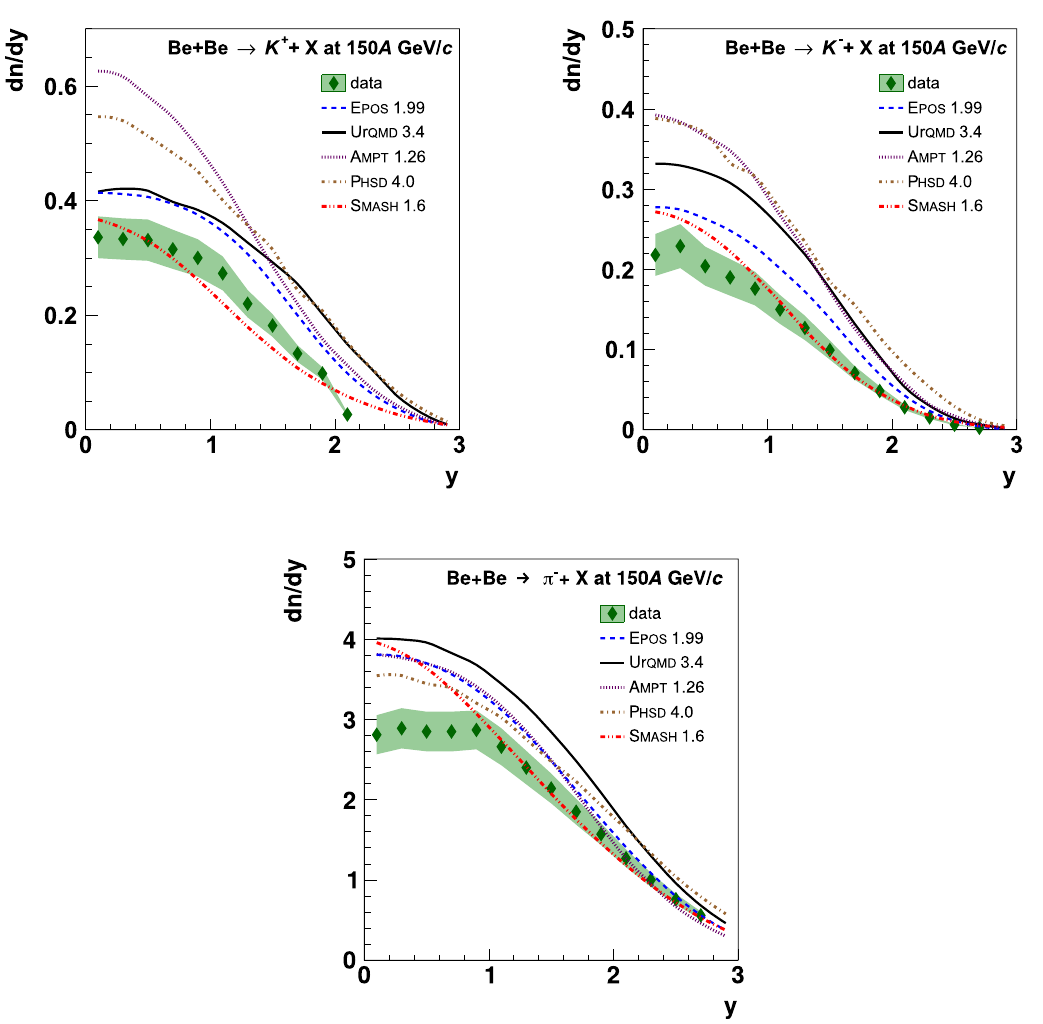
Fig. 35 Comparison of the K + (left), K − (right) and π − (bot- tom) rapidity spectra for the 20% most central Be+Be collisions at 150 A GeV / c with models: Epos 1.99 (blue dashed line), U r qmd 3.4